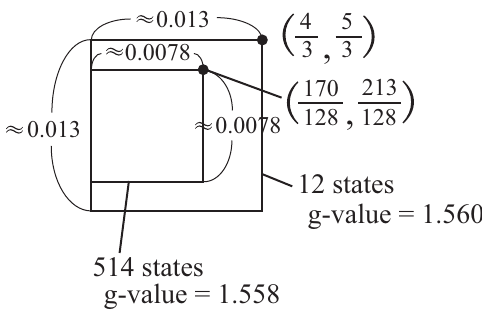
Figure 7 . Approximation of a